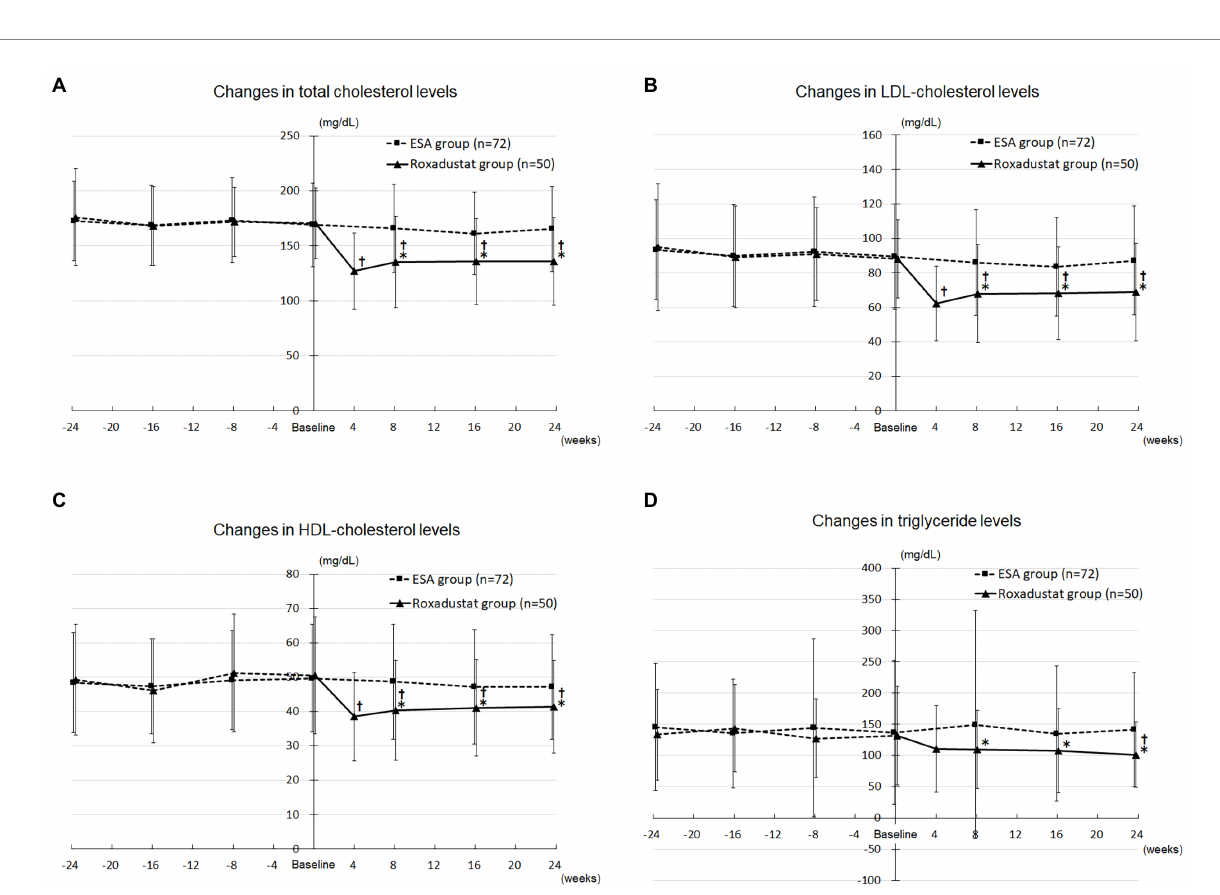
FIGURE 5 Lipid metabolism. (A) Changes in total cholesterol levels in the roxadustat and ESA groups. (B) Changes in LDL-cholesterol levels in the roxadustat and ESA groups. (C) Changes in HDL-cholesterol levels in the roxadustat and ESA groups. (D) Changes in triglyceride levels in the roxadustat and ESA groups. ESA, erythropoiesis-stimulating agent; HDL, high-density lipoprotein; LDL, low-density lipoprotein. *, value of p < 0.05 versus the ESA group; †, value of p < 0.05 versus